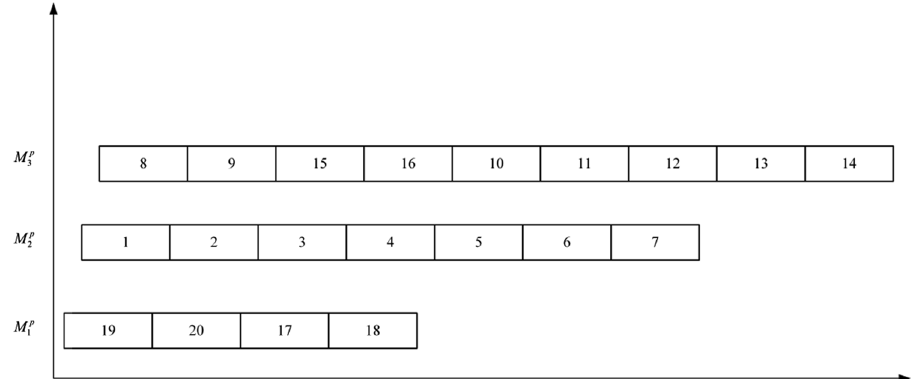
Fig. 4 The jobs processing sequence in stage